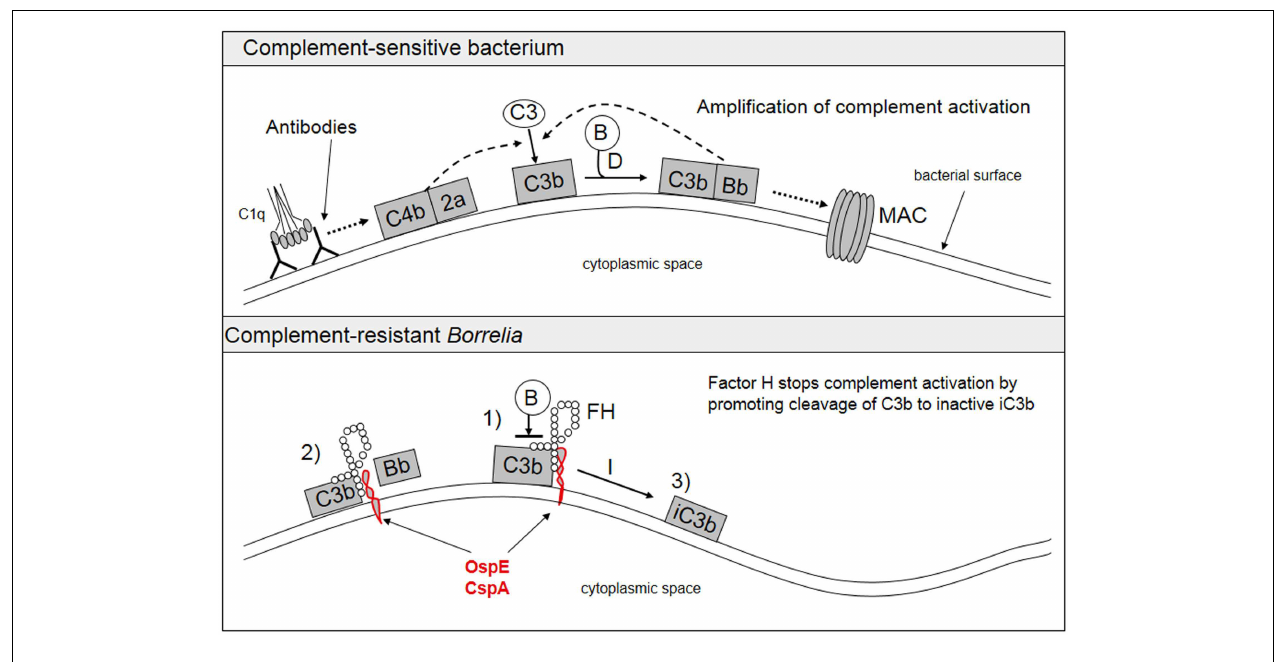
target for complement attack.The lower part shows how borrelial OspE/CspA (or any other similar microbial protein) binds factor H to block complement activation on the bacterial surface. FH, factor H; B, factor